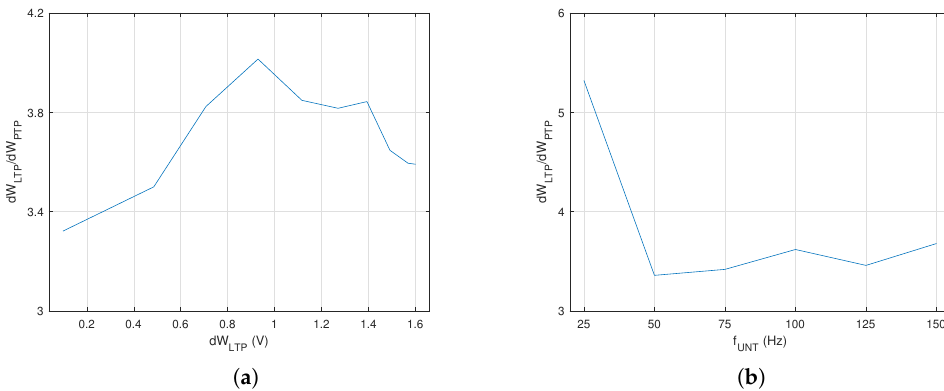
Figure 5. ( a ) Variation in the ratio r W with synaptic weight; ( b ) the ratio of synaptic weight variation between PTP and LTP after 2 s of training .